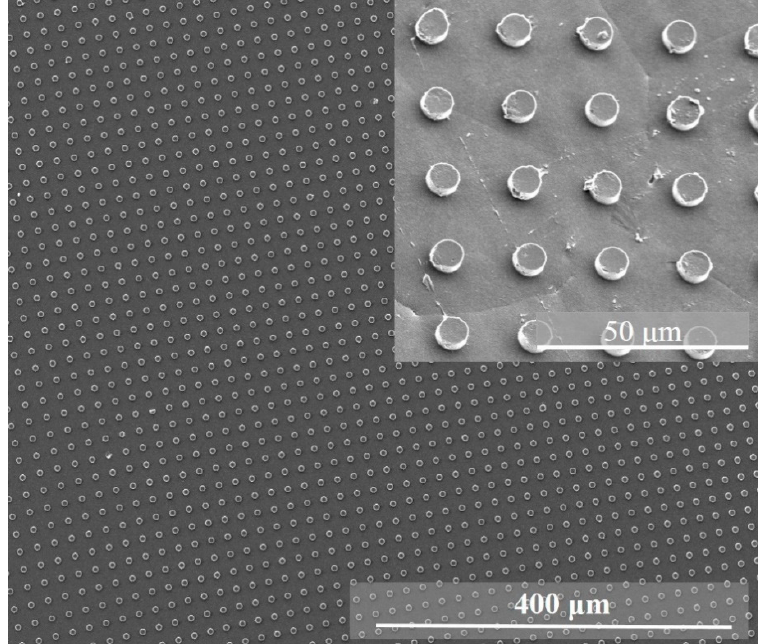
Figure 3. Scanning electron microscopy (SEM) image of the imprinted PVDF micropillar arrays. As an inset an image with a higher magnification is presented.